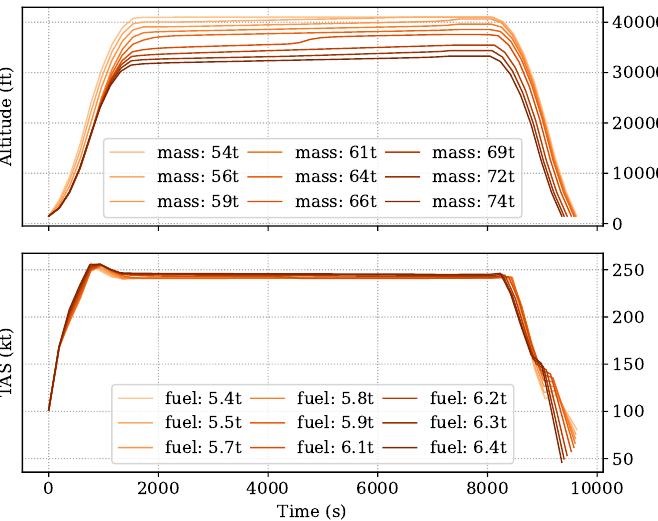
Figure 7. Fuel optimal trajectories under different takeoff weight (A320, optimized for fuel consumption).